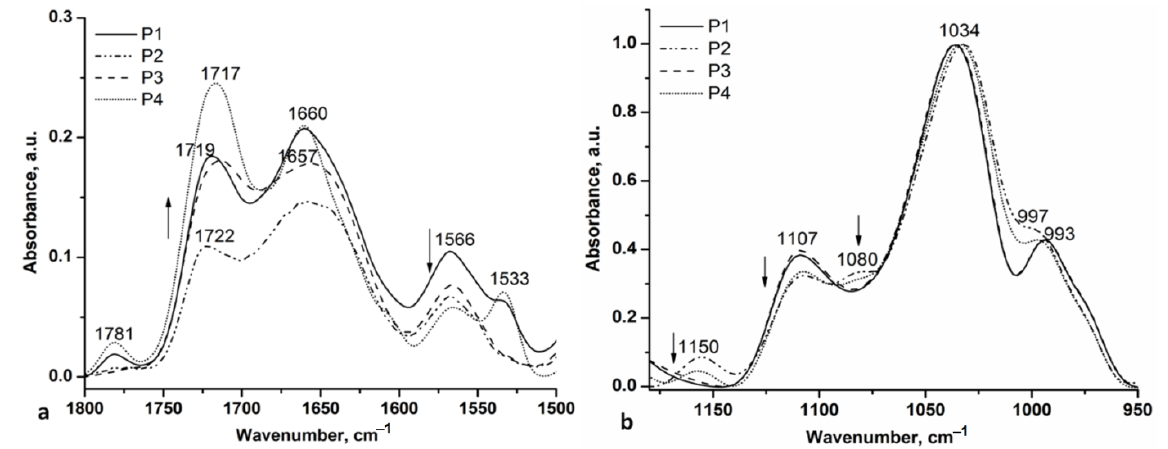
Figure 3. Carbonyl, amide II ( a ), and C-O-C ( b ) spectral regions for P1-P4 hydrogel